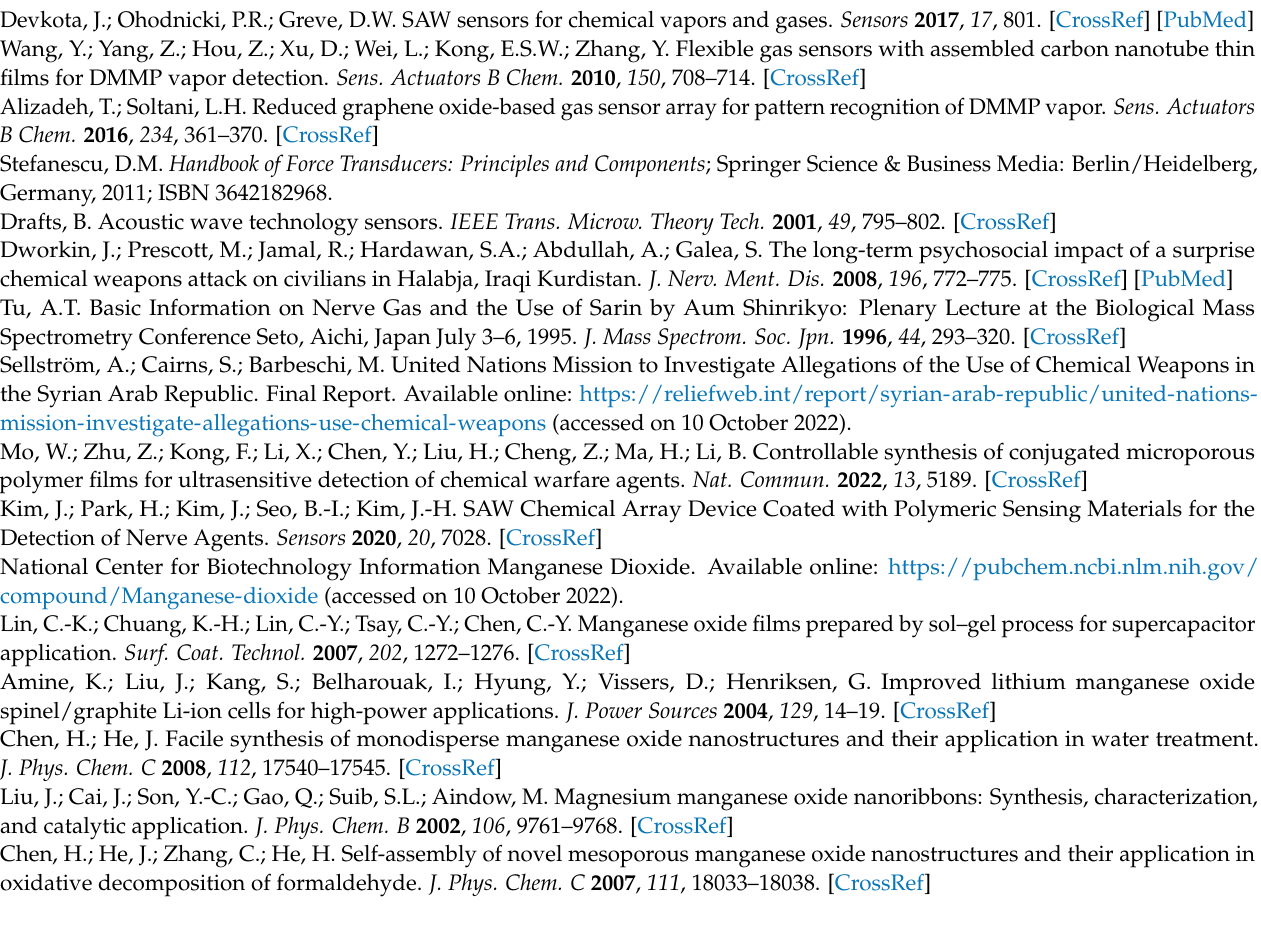
(Figure S2), schematic diagram of the gas sensing system in the QCM and its setup (Figures S3 and S5), schematic diagram of the gas sensing system in the SAW sensor and its setup (Figures S4 and S6), XRD (Figure S7), FE-SEM (Figure S8), and FE-TEM (Figure S9) of microcrystalline